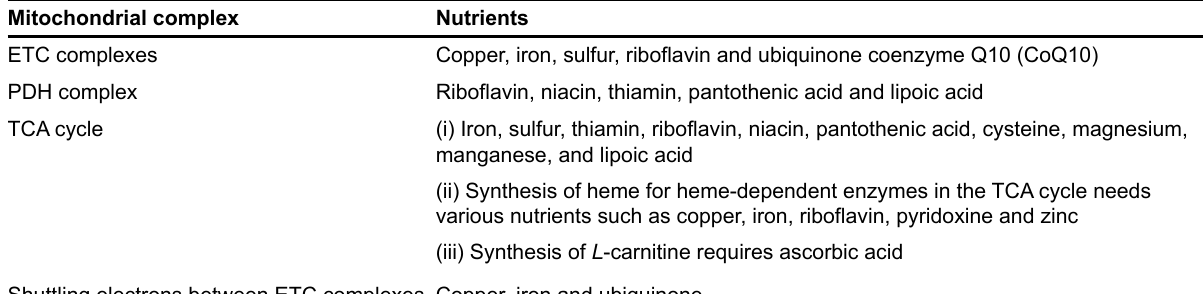
Shuttling electrons between ETC complexes Copper, iron and